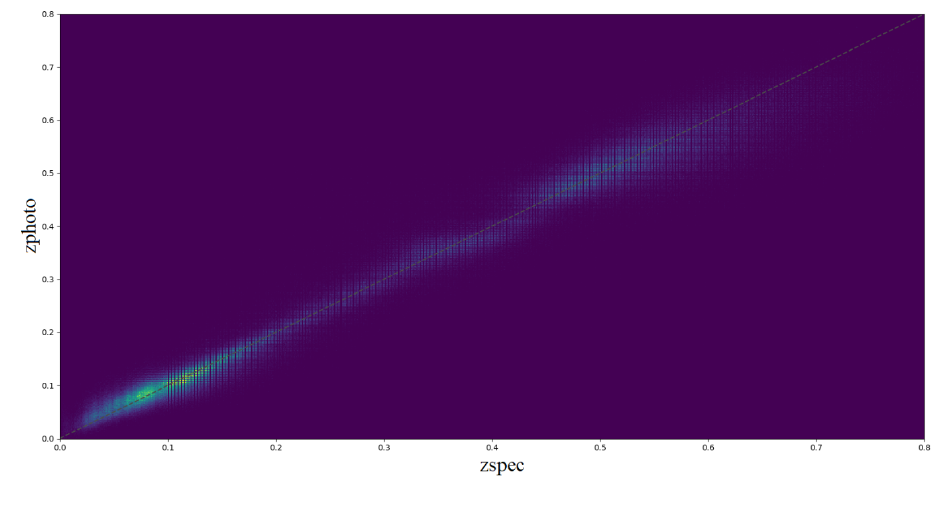
Figure 1. XGBoost model of first training set